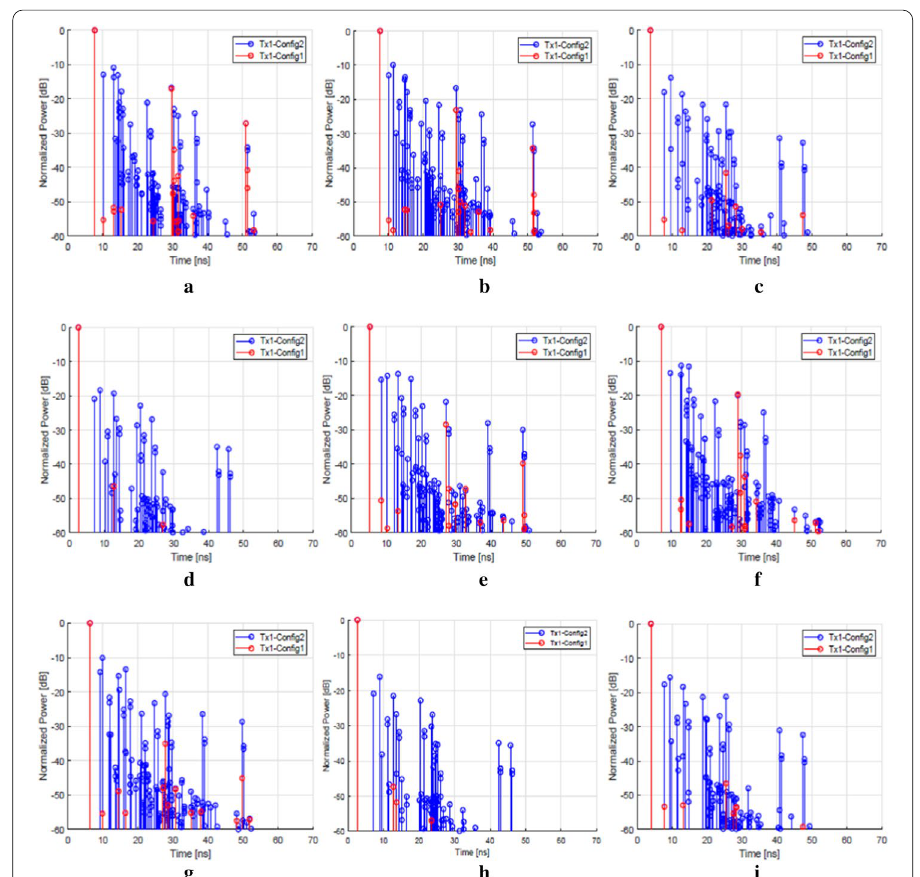
Fig. 14 Power delay profile. a Pos 1, b Pos 2, c Pos 3, d Pos 4, e Pos 5, f Pos 6, g Pos 7, h Pos 8, and i Pos